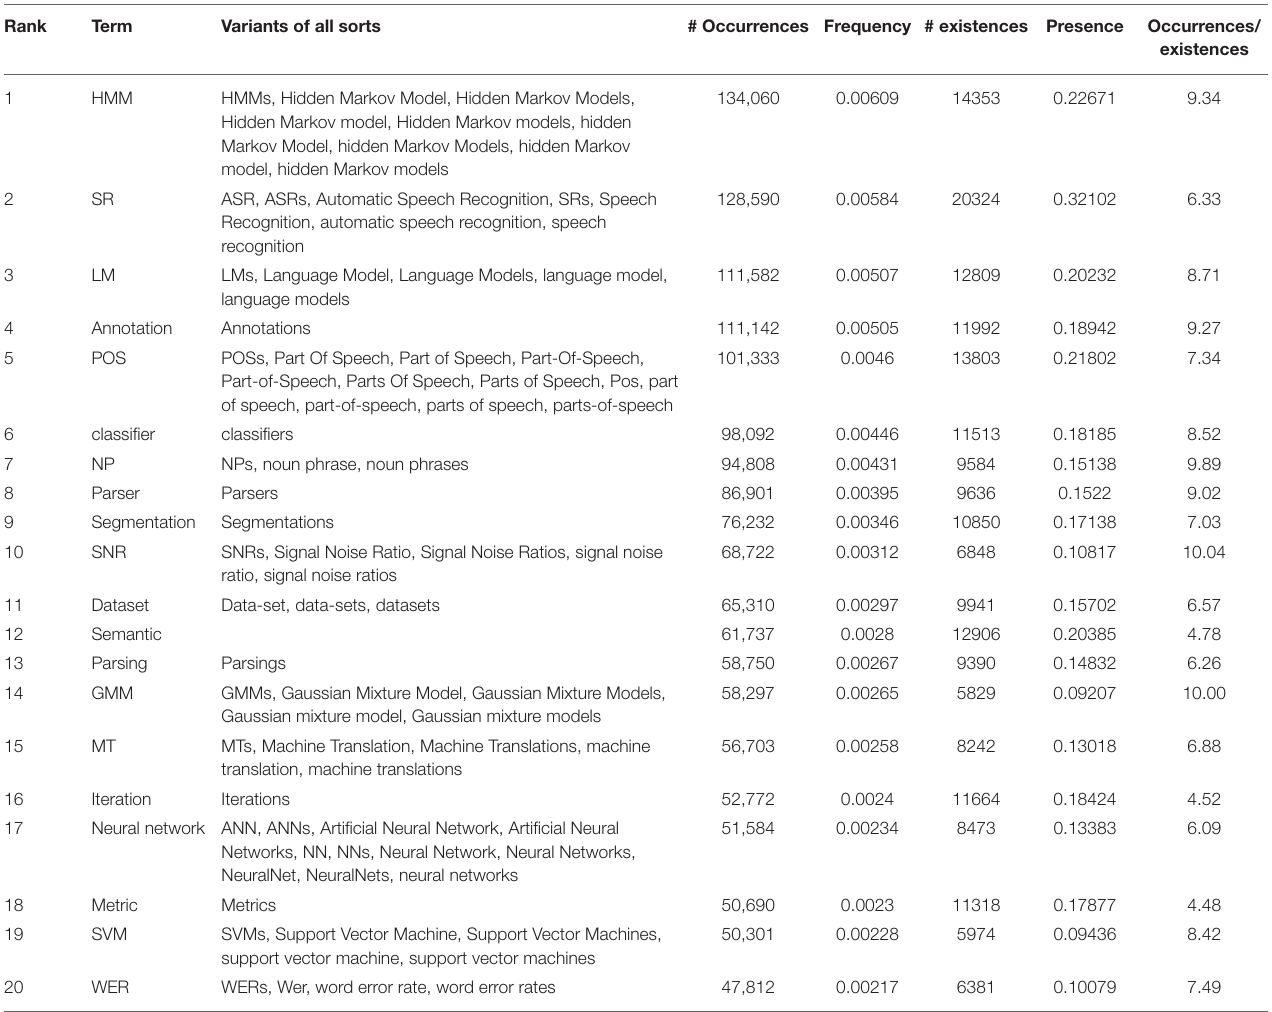
TABLE 1 | Twenty most frequent terms overall, with number of occurrences and existences, frequency and